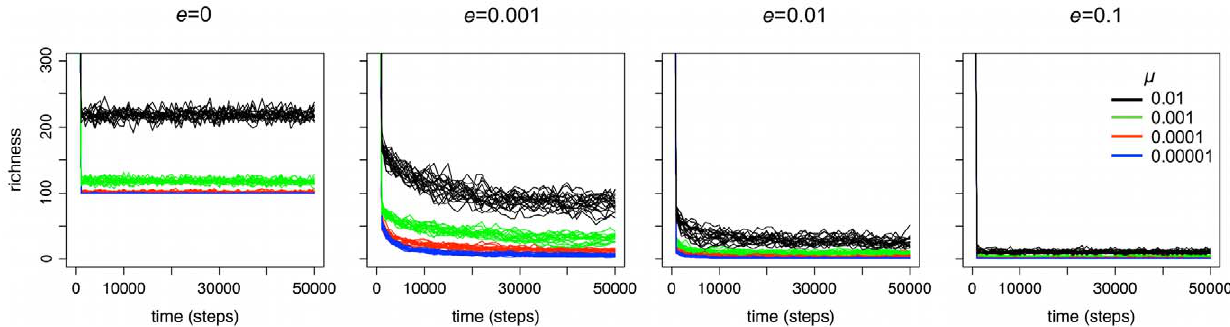
Figure 1. Equilibrium conditions for all combinations of m and e tested here. Richness decreases quickly from an initial value of 2500 and cultural diversity reaches equilibrium by the 50,000 th time step in all populations. Each line represents the results of a unique simulation run.